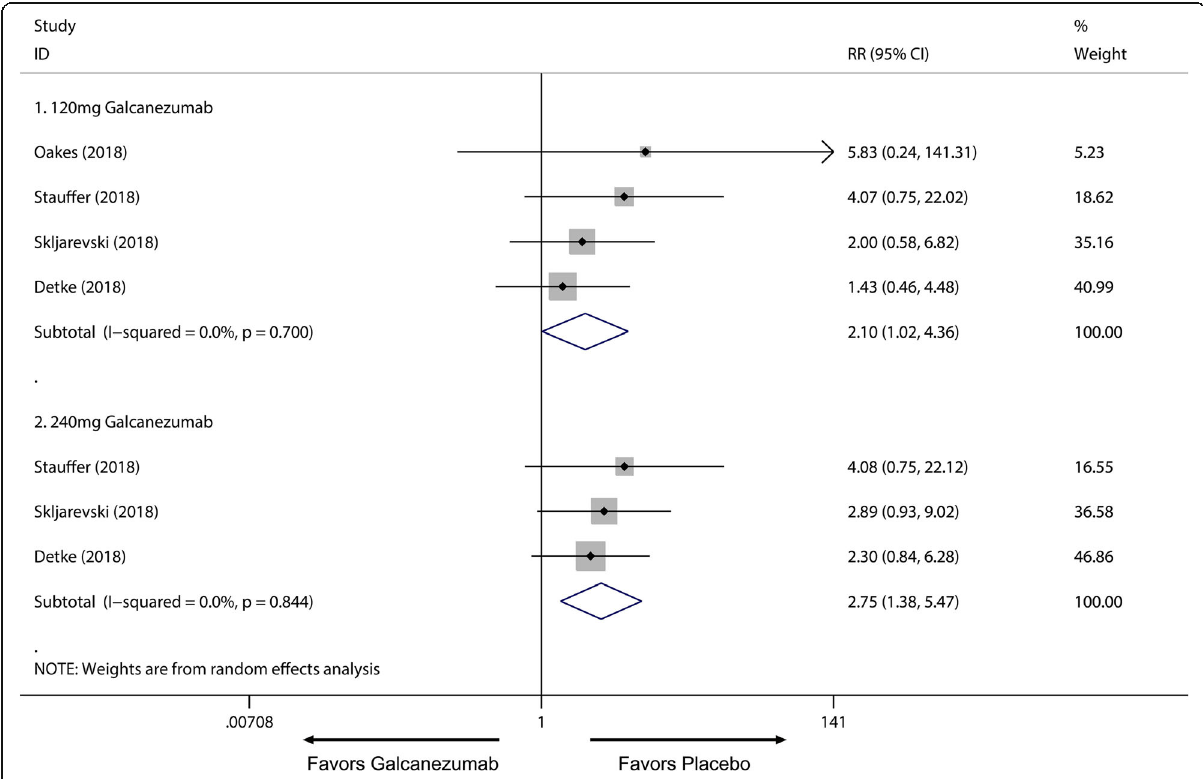
Fig. 8 Pooled SAEs relative risk in 120 mg and 240 mg galcanezumab group. RR relative